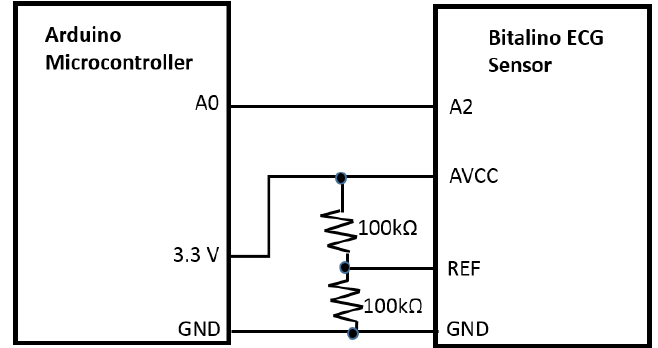
Figure 2. Circuit diagram of the prototype.